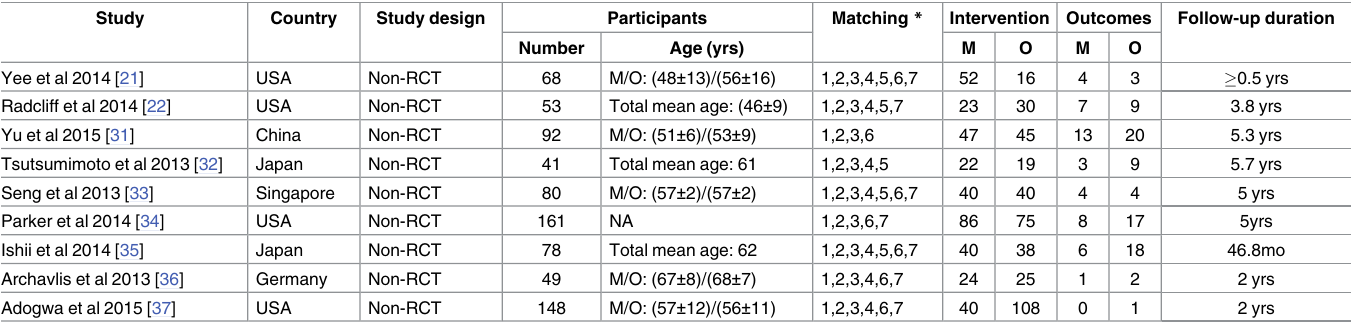
Table 1. The main characteristics of the nine included